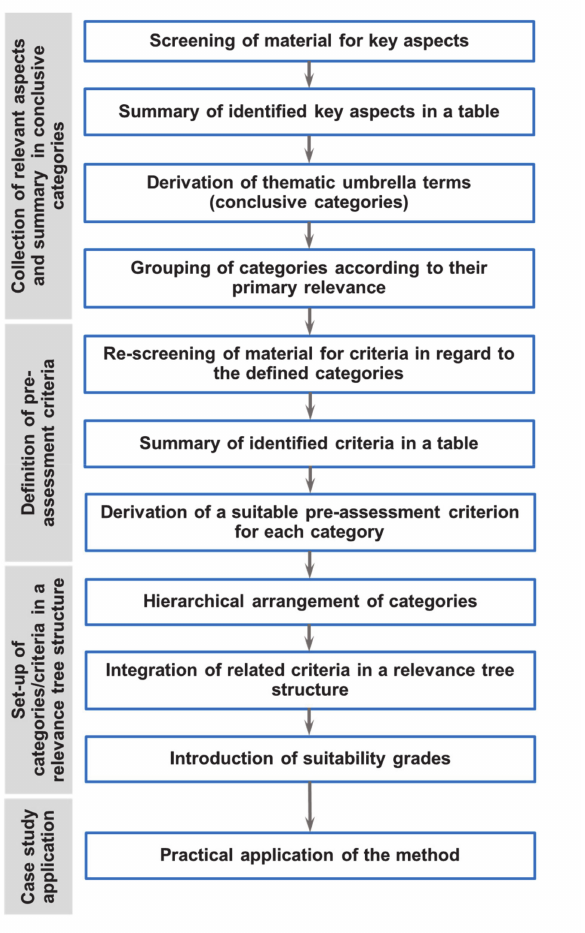
Figure 1. Steps for developing the pre-assessment procedure (own